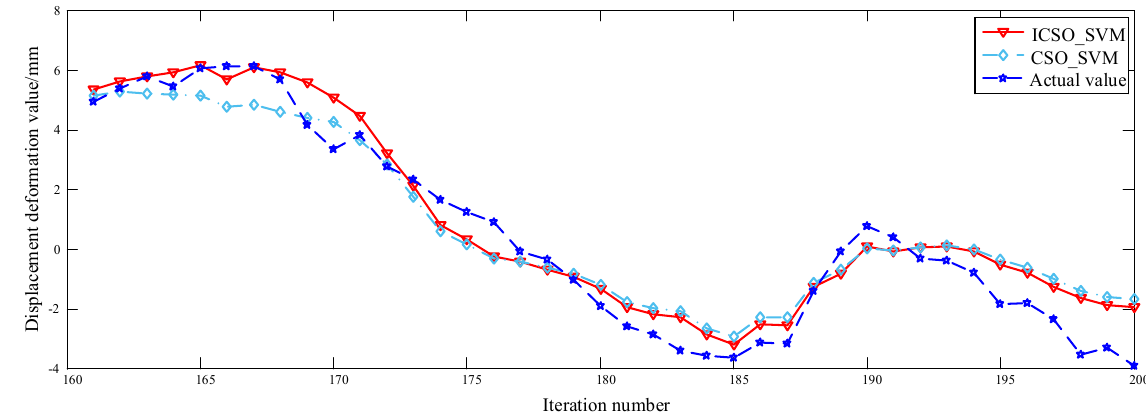
Figure 10. Prediction curve of optimized support vector machine model.